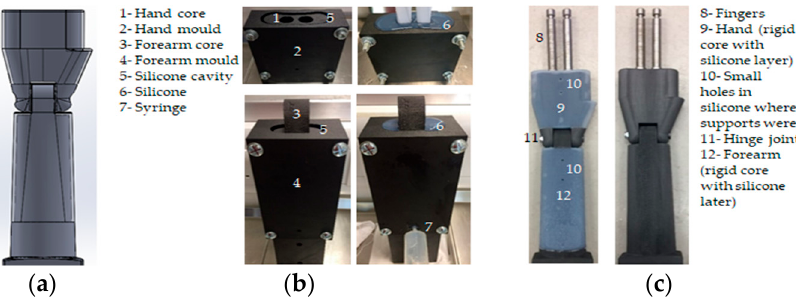
Figure 1. ( a ) Compliant surrogate CAD; ( b ) silicone moulding; ( c ) compliant surrogate ( left ) and rigid surrogate ( right